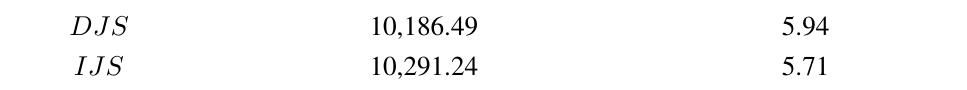
Table 4. Total execution time for protocols DJS and IJS using the same random number in ECIES